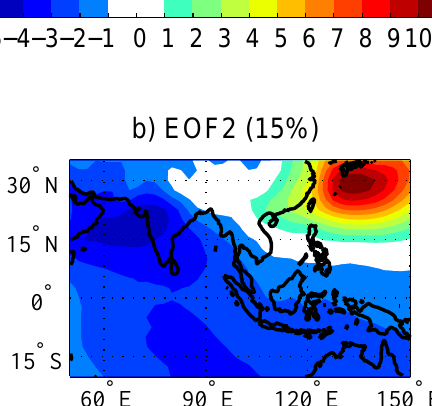
Fig. 1. JJAS climatology of the ERA-40 SLP and 850hPa wind field over the Asian monsoon region. SLP units: 2hPa ,andthemaximumwindspeedis 18ms − 1 .